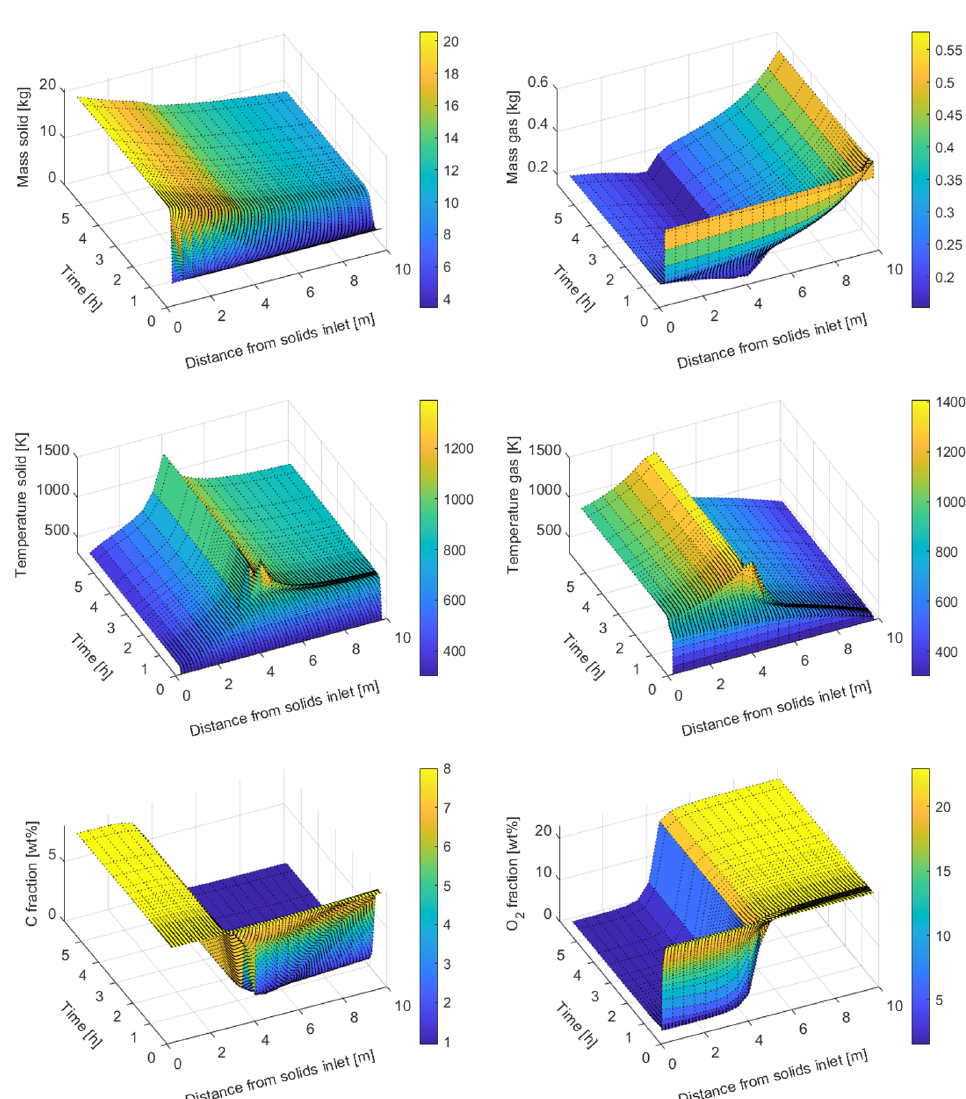
Figure 12. Time progression of solid and gas mass ( top ), solid and gas temperature ( middle ), organic residue concentration ( bottom left ), and oxygen concentration ( bottom right ) along the kiln for Case